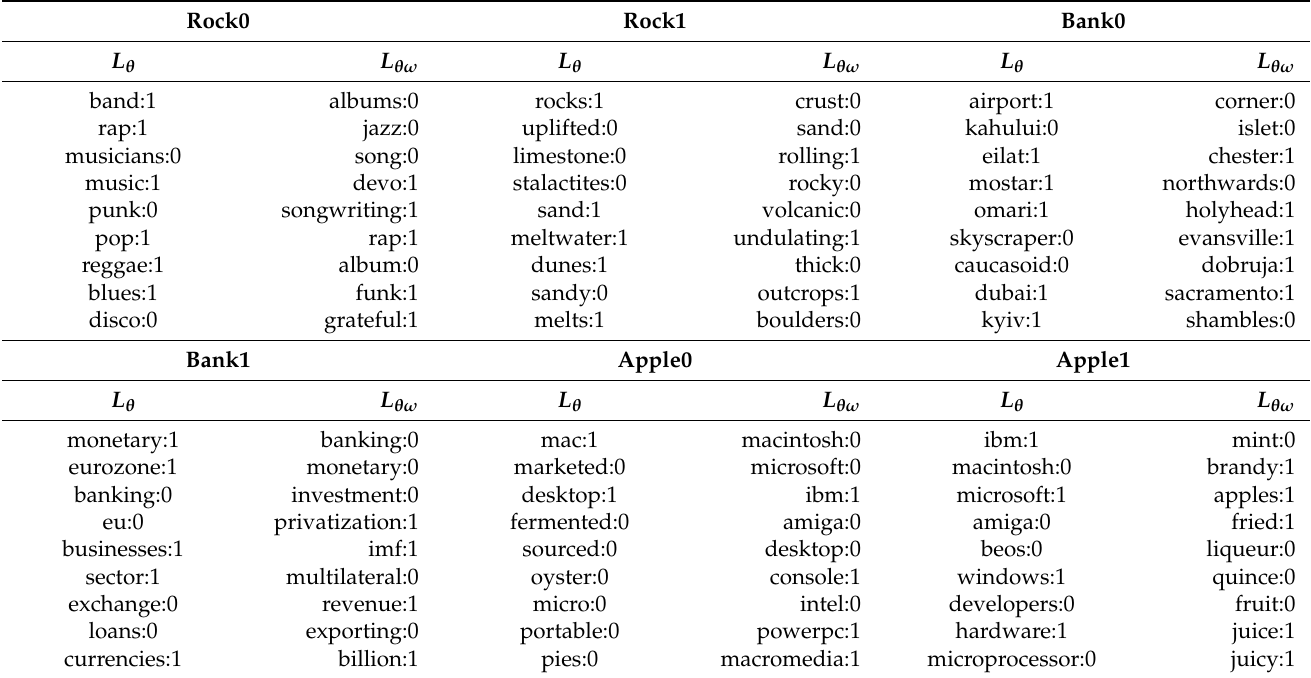
Table 8. Nearest neighbor words (cosine similarity) using text8 dataset for both objectives ( L θ and L θω ) in the Multimodal word Distributions settings.